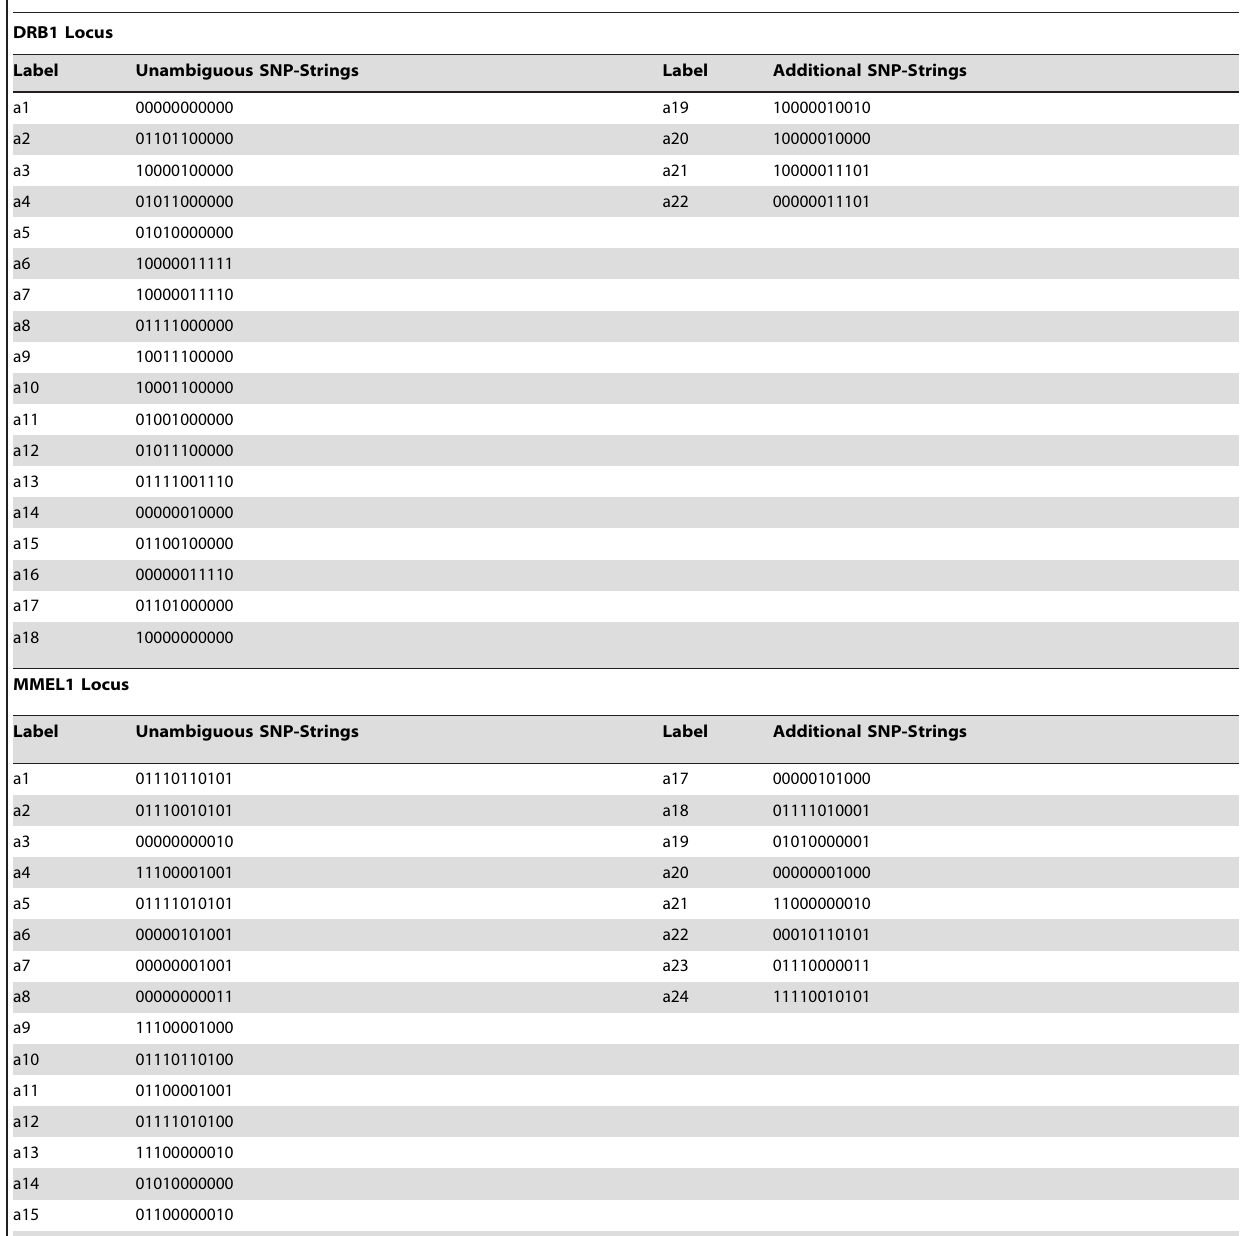
Table 4. SNP-Strings ‘‘identified’’ by the SNP-String